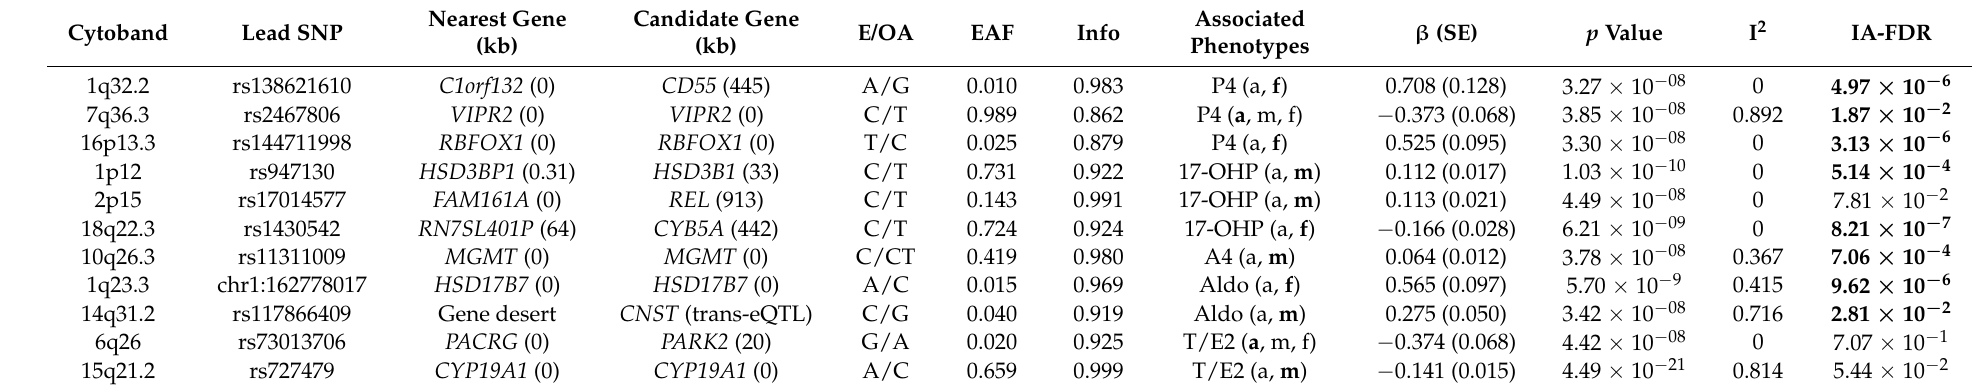
Table 2. Summary statistics of novel loci. Per locus, we report the strongest association statistics for the best-associated variant. In parenthesis, we report analysis groups showing genome-wide significance (a, all; m, males; f, females). The analysis group showing the strongest significance is displayed in bold. Abbreviation: E/OA, effect/other allele; EAF, effect allele frequency (mean of LIFE-Adult and LIFE-Heart); Info, imputation info-score (minimum of LIFE-Adult and LIFE-Heart); IA-FDR, adjusted p -value of interaction test, marked in bold if significant. See supplementary material for justification of proposed candidate